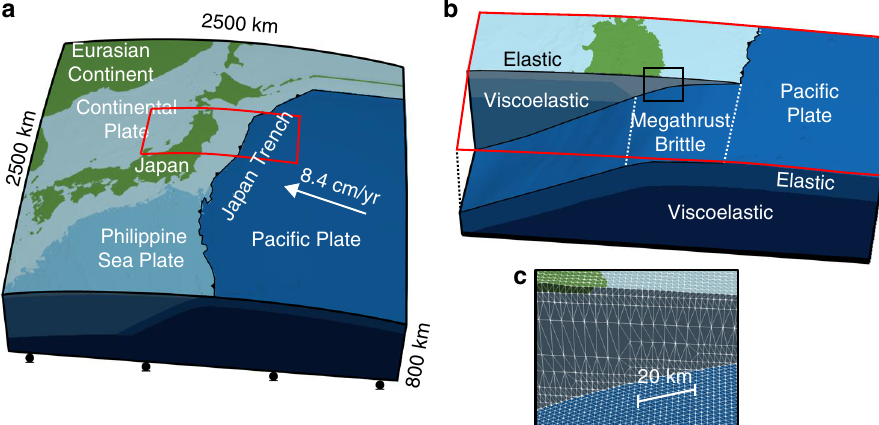
Fig. 3 The fi nite-element model used in our study. a Overview, b close-up view for the region of the red rectangle in a with the location of the megathrust and c close-up view for the region of the black rectangle in b with fi nite-element mesh patterns. The elements with the same color are in the same structural component (we have six of them, elastic and viscoelastic layer in three plates). The green color is used to distinguish the elements that are located above sea level. The green elements have the same material properties as those in the continental